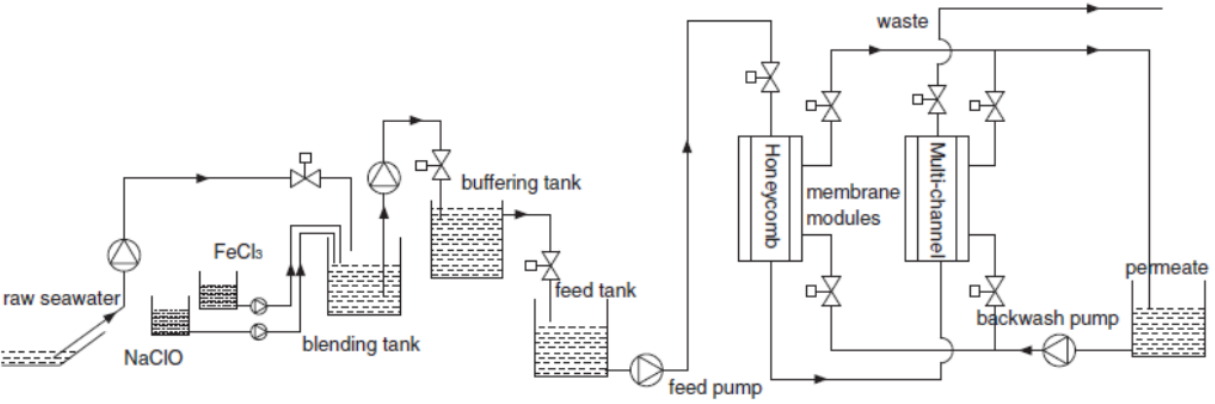
Figure 6. Representation diagram of CM filtration system [229]. Reprinted with permission.